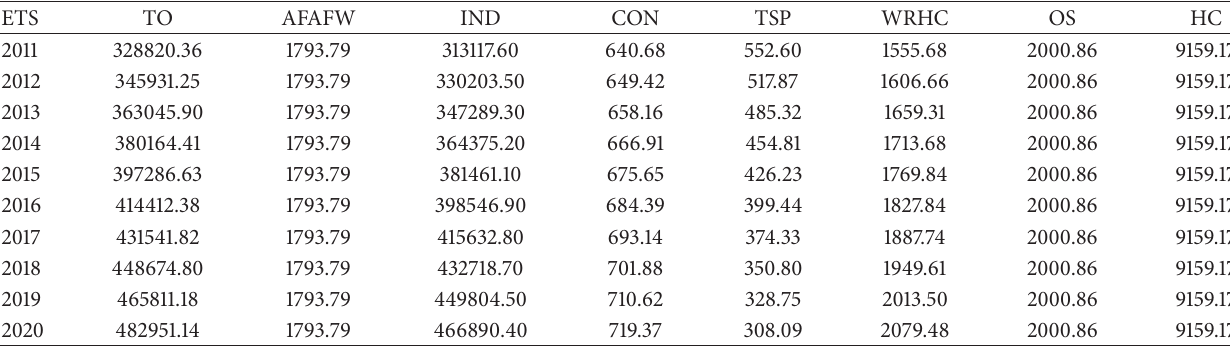
Table 4: Forecasting result of coal consumption on sector by ETS method.